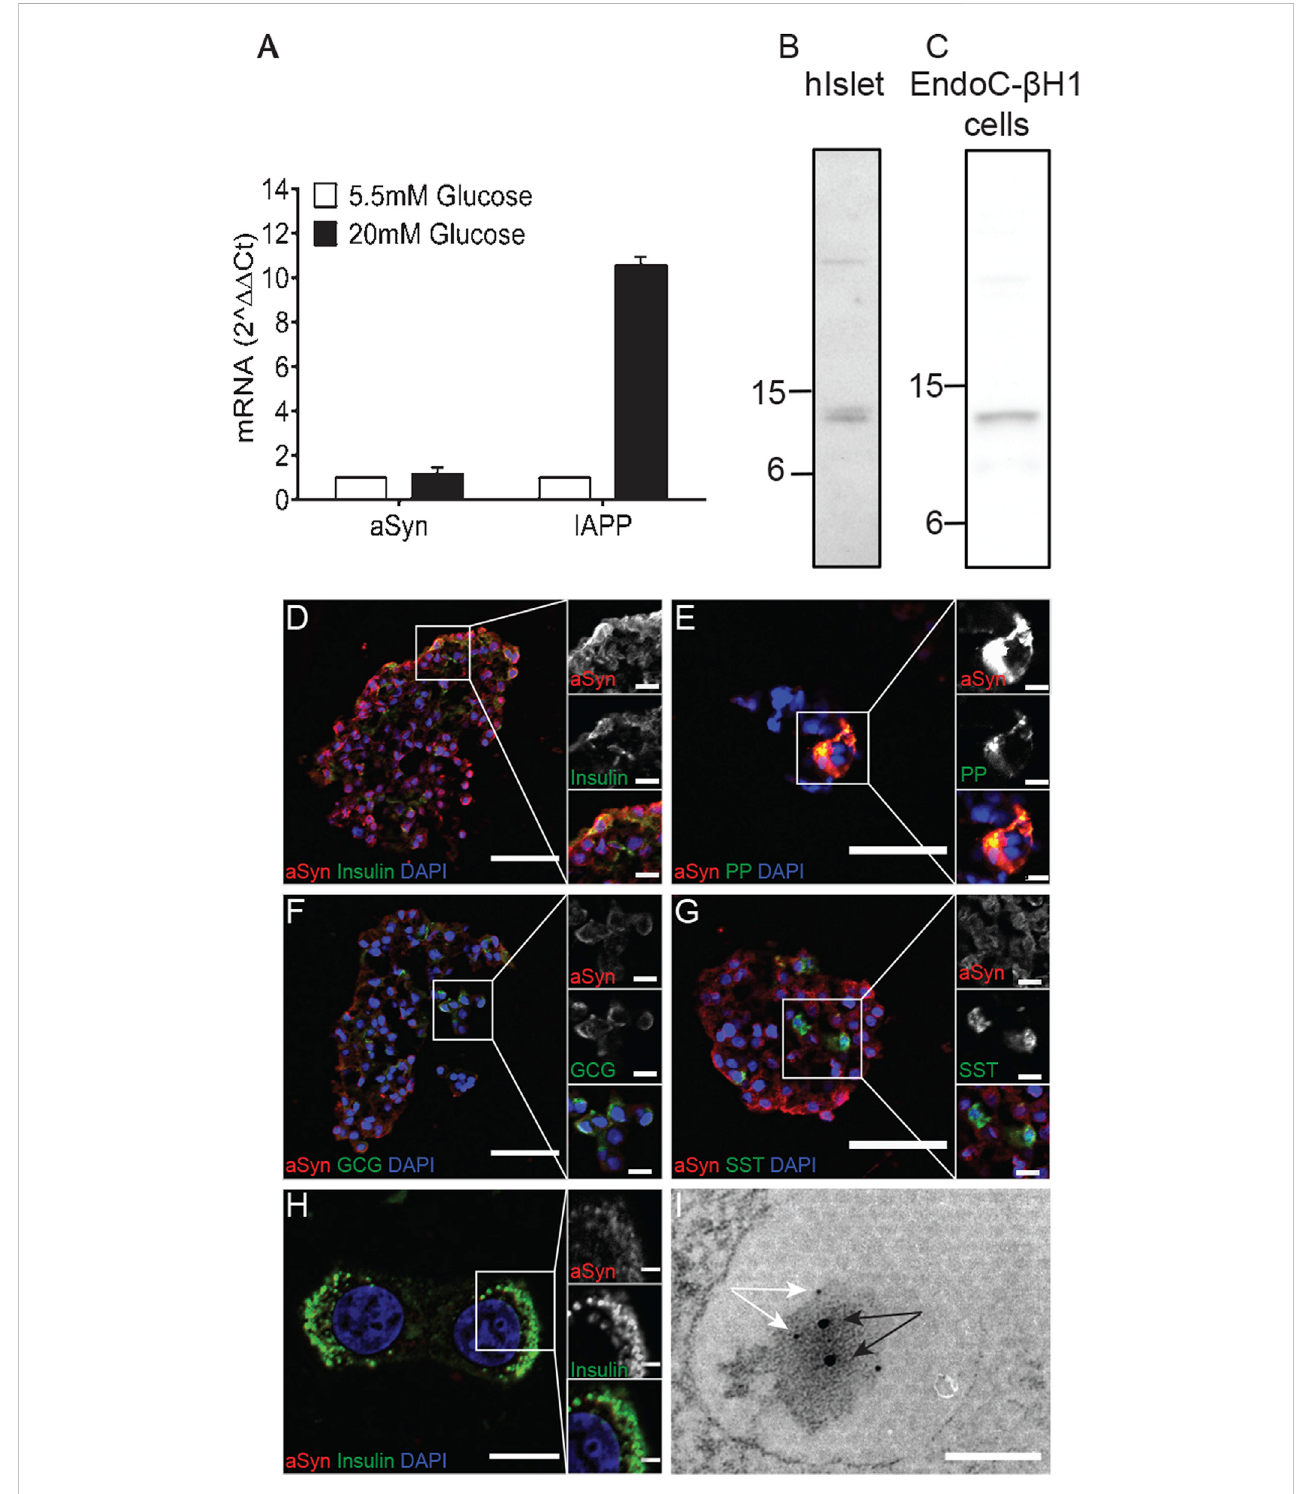
FIGURE 1 ASyn is presentin human islets and human EndoC- β H1cells. Human islets ( n = 2)were divided into two groups and cultured in normal glucose(5.5 mM) or high glucose (20 mM) for 2 days before being analyzed for aSyn mRNA and IAPP mRNA. Data were presented as fold changes, and expression of aSyn mRNA and IAPP mRNA were normalized to GUSb and relative to normal glucose. (A) Culturing in high glucose slightly increased aSyn mRNA levels by 1.18- fold, whereas the same treatment increased IAPP mRNA by 10-fold. Western blot data con fi rm the presence of aSyn in (B) human islets and (C) human EndoC- β H1 cells as 14 kDa band using aSyn-speci fi c antibody Syn-1. The localization of aSyn in human islets was investigated using double- immuno fl uorescencestaining.ASynreactivity co-localized with (D) insulinand (E) pancreaticpolypeptide,partiallyco-localized with (F) glucagon,butnoco- localization occurred with (G) somatostatin. The co-localization of aSyn and insulin reactivity was also detected in (H) EndoC- β H1 cells. (I) In the electron micrograph, aSyn (10 nm gold particles, black arrows) and insulin (5 nm gold particles, white arrows) reactivity were both detected in secretory granules of β cells, especially around the dense core of granules. Scale bars are 50 μ m and 10 µm in insets (D – G) , 10 μ m and 2 µm in inset (H) , and 100 nm in (I)